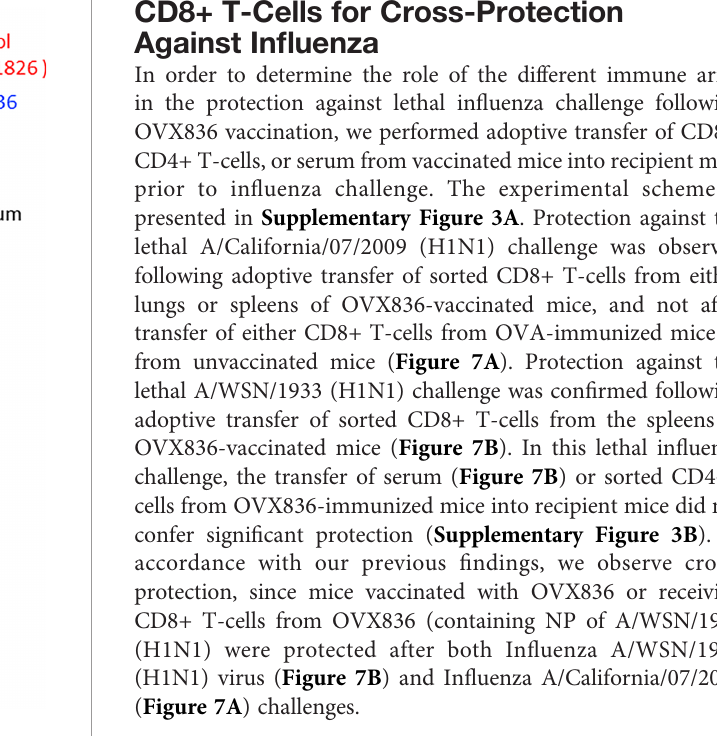
FIGURE 4 | OVX836 activates CD8 a + DC and promotes effector T-cell responses in vitro. (A) Mean CD86 expression on puri fi ed CD8a + DCs incubated for 18 h with 2 µg/ml NPm (36 nM NP), NPwt (36 nM NP), OVX836 (32 nM NP), or a positive control. (B) Graph shows the percentage of speci fi c CD8+ T cells that were positive for IFN g , measurement of IFN g production by NP-speci fi c CD8 + T-cells incubated for 6 h with antigen-loaded DCs (as indicated) at a 5:1 (DC/CD8) ratio, then analyzed by fl ow cytometry. CD8 + T- cells used in the assay were isolated from the spleen of mice immunized